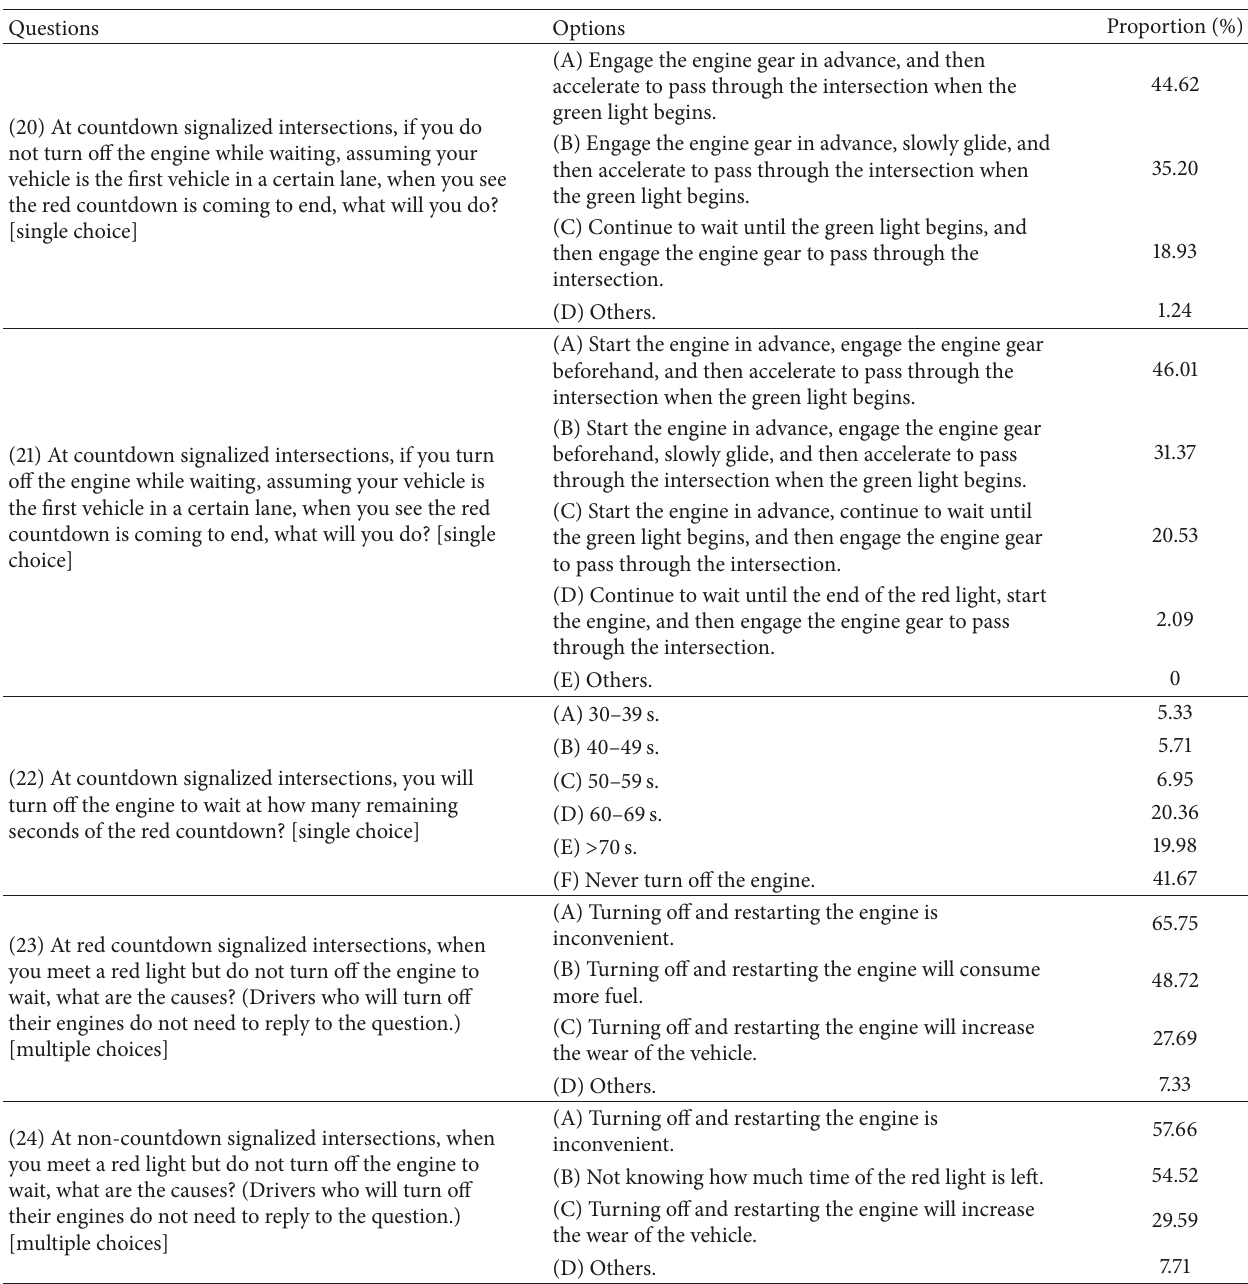
Table 6: Behaviors on whether engines should be turned off while waiting for the green light.